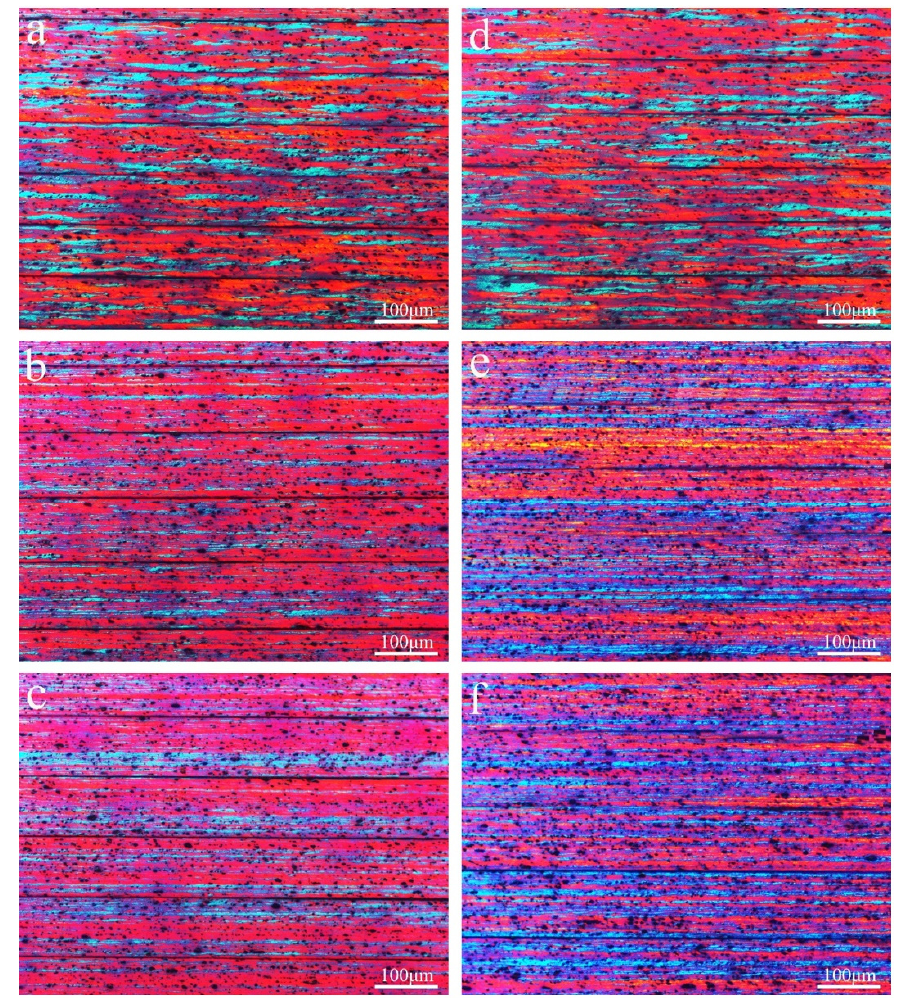
Figure 2. Longitudinal section microstructure of the foil alloys at different states: ( a , d ) Al-0.2Fe-0.06Cu; ( b , e ) Al-0.2Fe-0.06Cu-0.1La; ( c , f ) Al-0.2Fe-0.06Cu-0.15La.